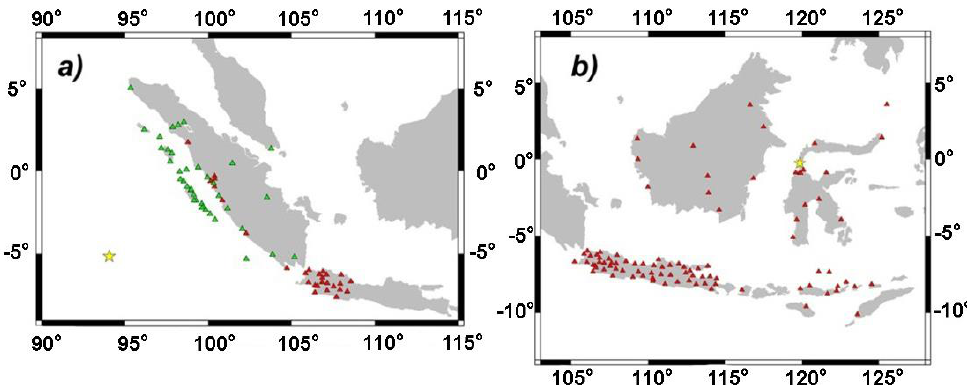
Figure 1. GNSS stations from SUGAR array (green triangle) and INACORS (red triangle) used in ( a ) the 2016 West Sumatra earthquake, and ( b ) the 2018 Palu earthquake. The epicenters are marked with the yellow stars. Both were strike-slip